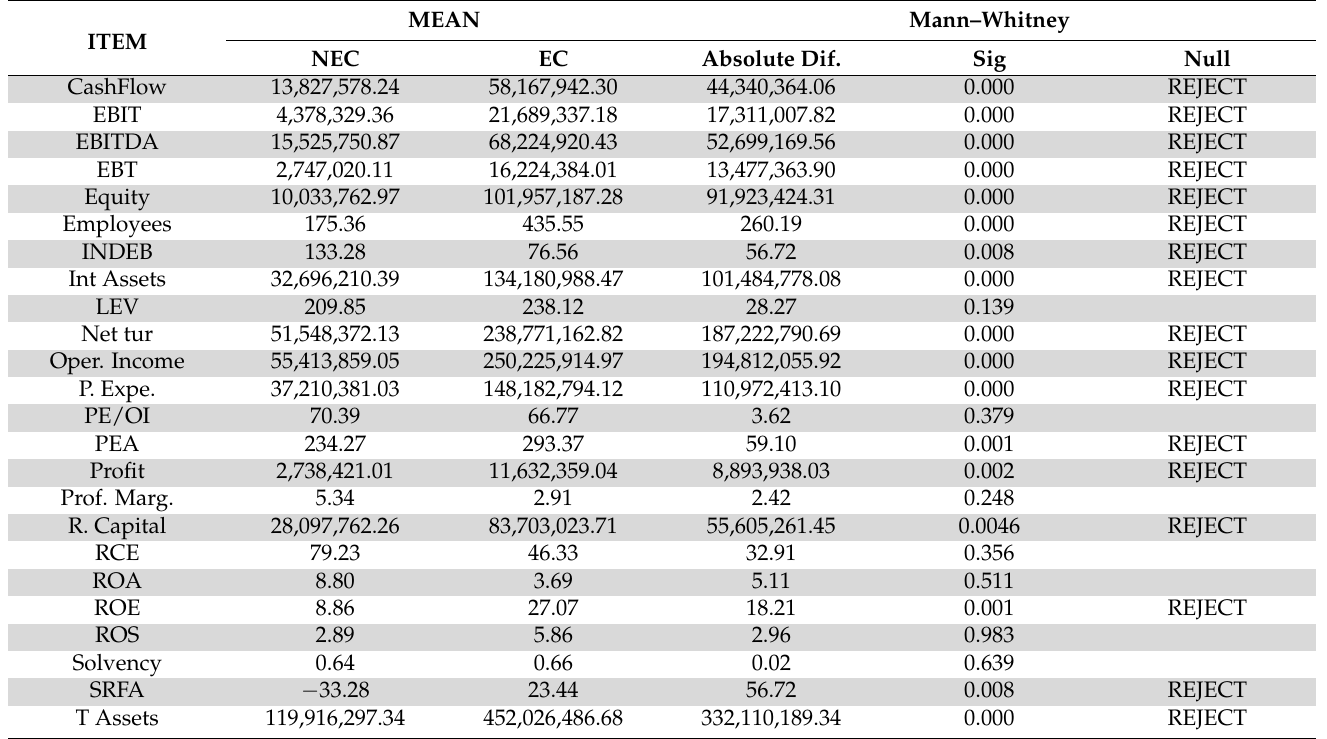
Table 3. Testing financial variables based on participation in European Competitions